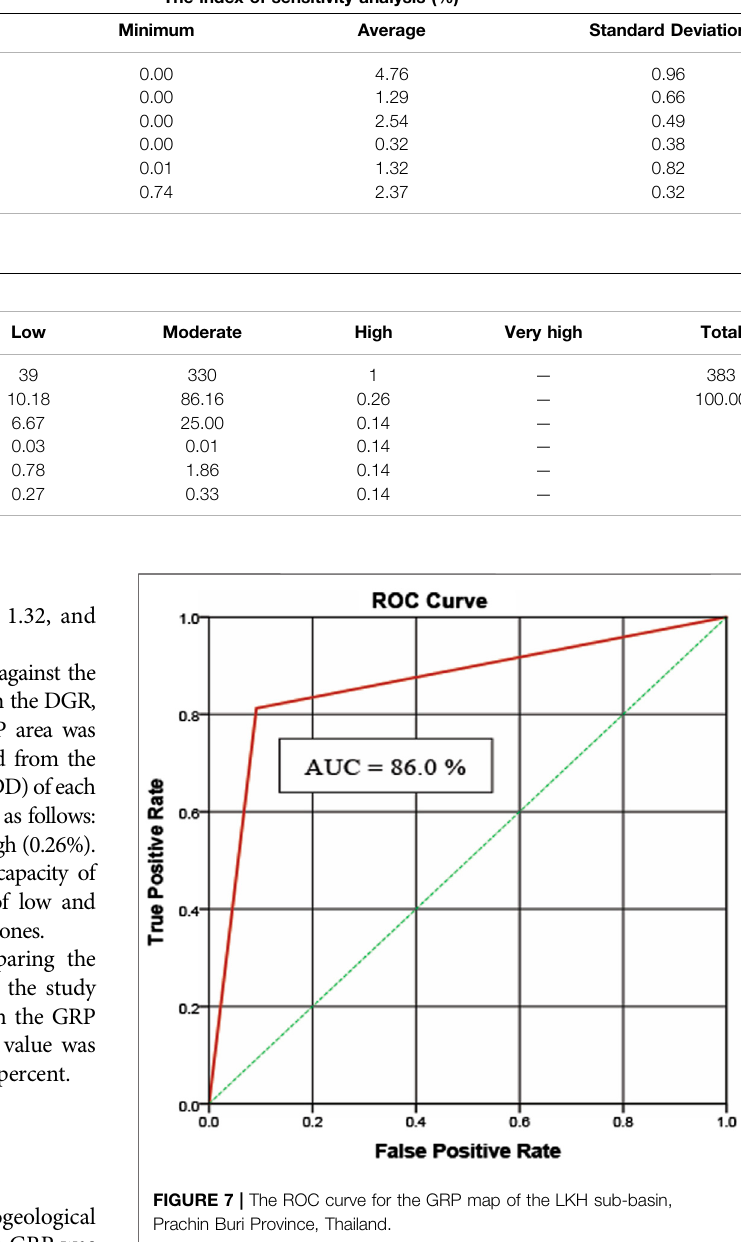
TABLE 6 | The sensitivity analysis by the map-removal method. In fl uencing factor removed